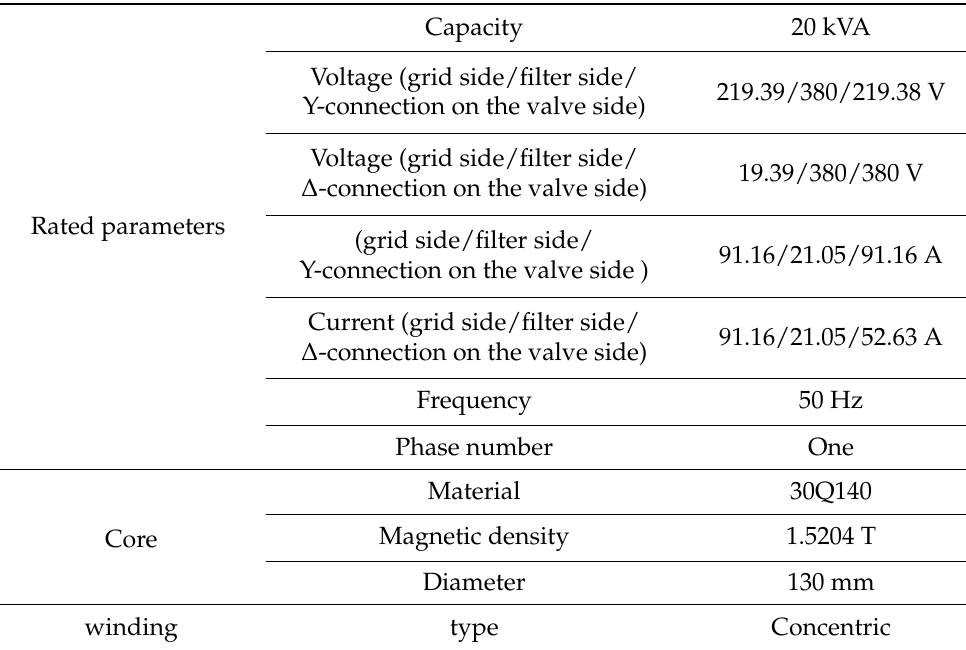
Table 1. Parameters of single-phase converter transformer prototype.